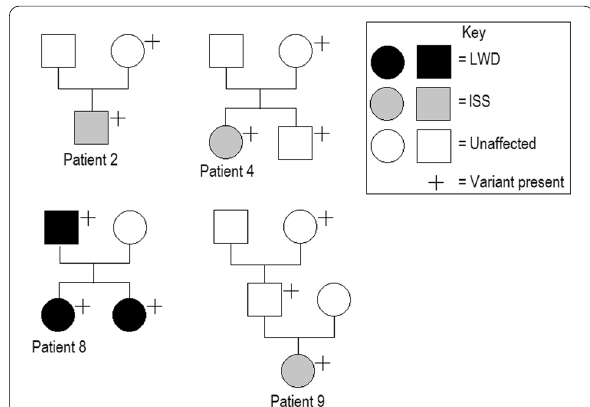
Fig. 2 Pedigrees and inheritance patterns of the four families where samples from additional family members were available